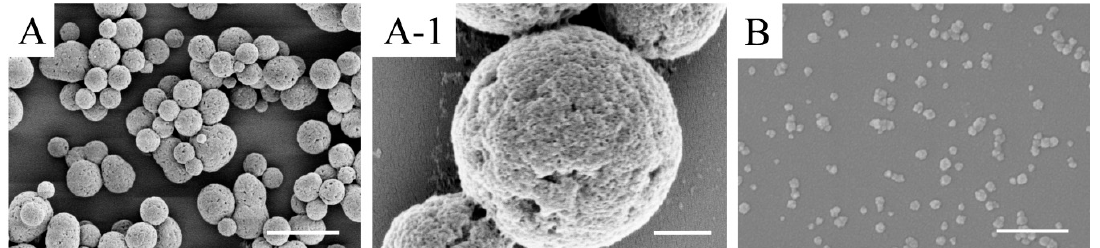
Figure 2. SEM images of silk fibroin particles. ( A ) silk fibroin microparticles (SFMPs); ( A-1 ) magnified image of image ( A ); ( B ) silk fibroin nanoparticles (SFNPs). Scale bars: ( A ) 5 μ m; ( A-1 ) 500 nm; ( B ) 400 nm.